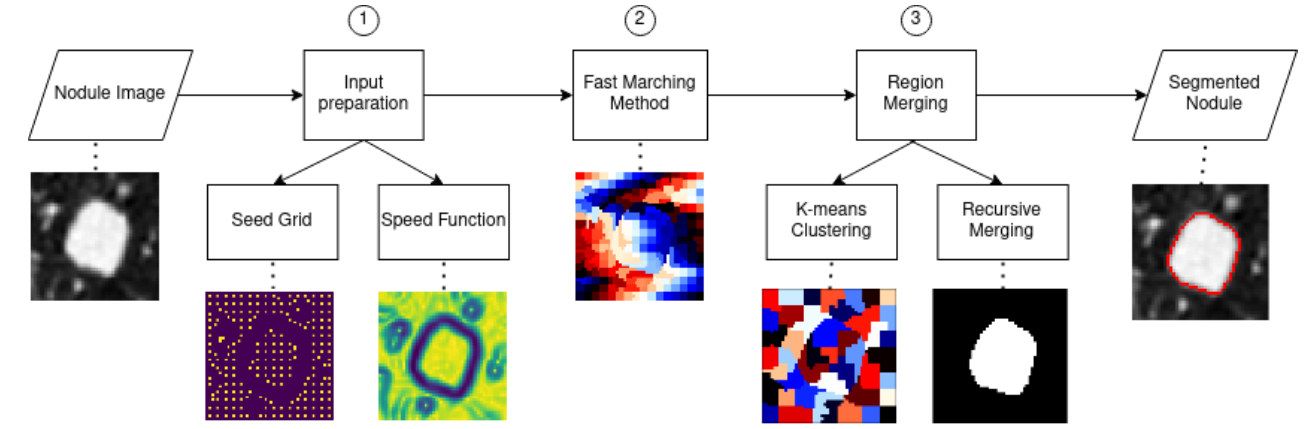
Figure 2. Flowchart of the proposed